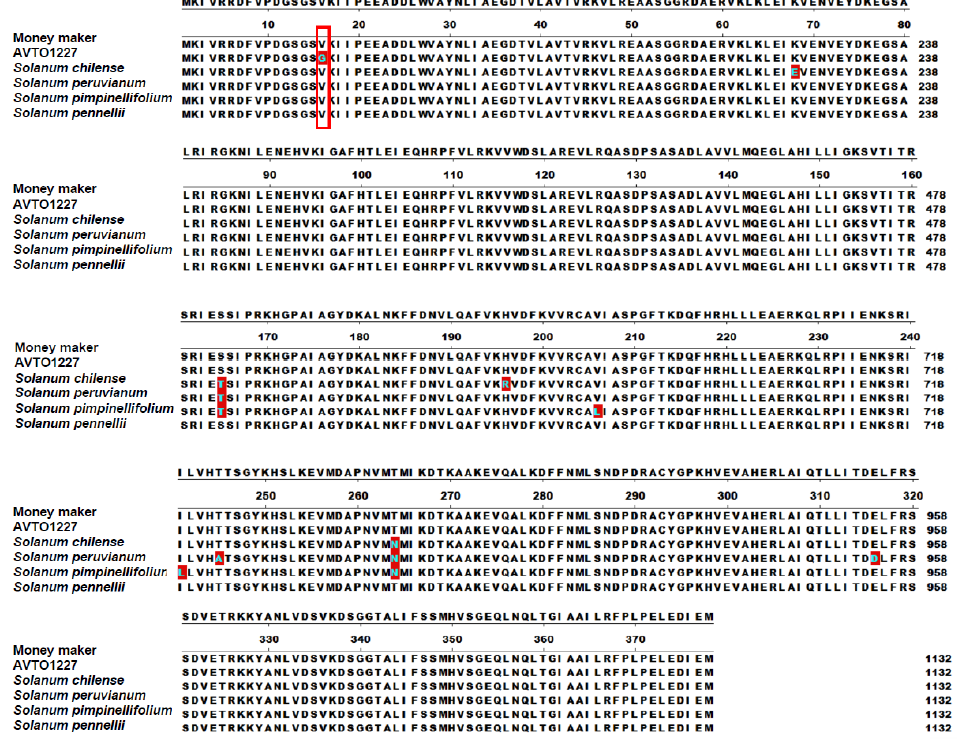
Figure 1. Alignment of the predicted amino acid sequences of Pelota genes from the susceptible tomato line Moneymaker, the resistant tomato line AVTO1227, Solanum chilense , Solanum peruvianum , Solanum pimpinellifolium , and Solanum pennellii . The difference between resistant and susceptible lines (valine vs. glycine at amino acid 16) is indicated with a red box. Residues that differ from Moneymaker are indicated in solid deep red.